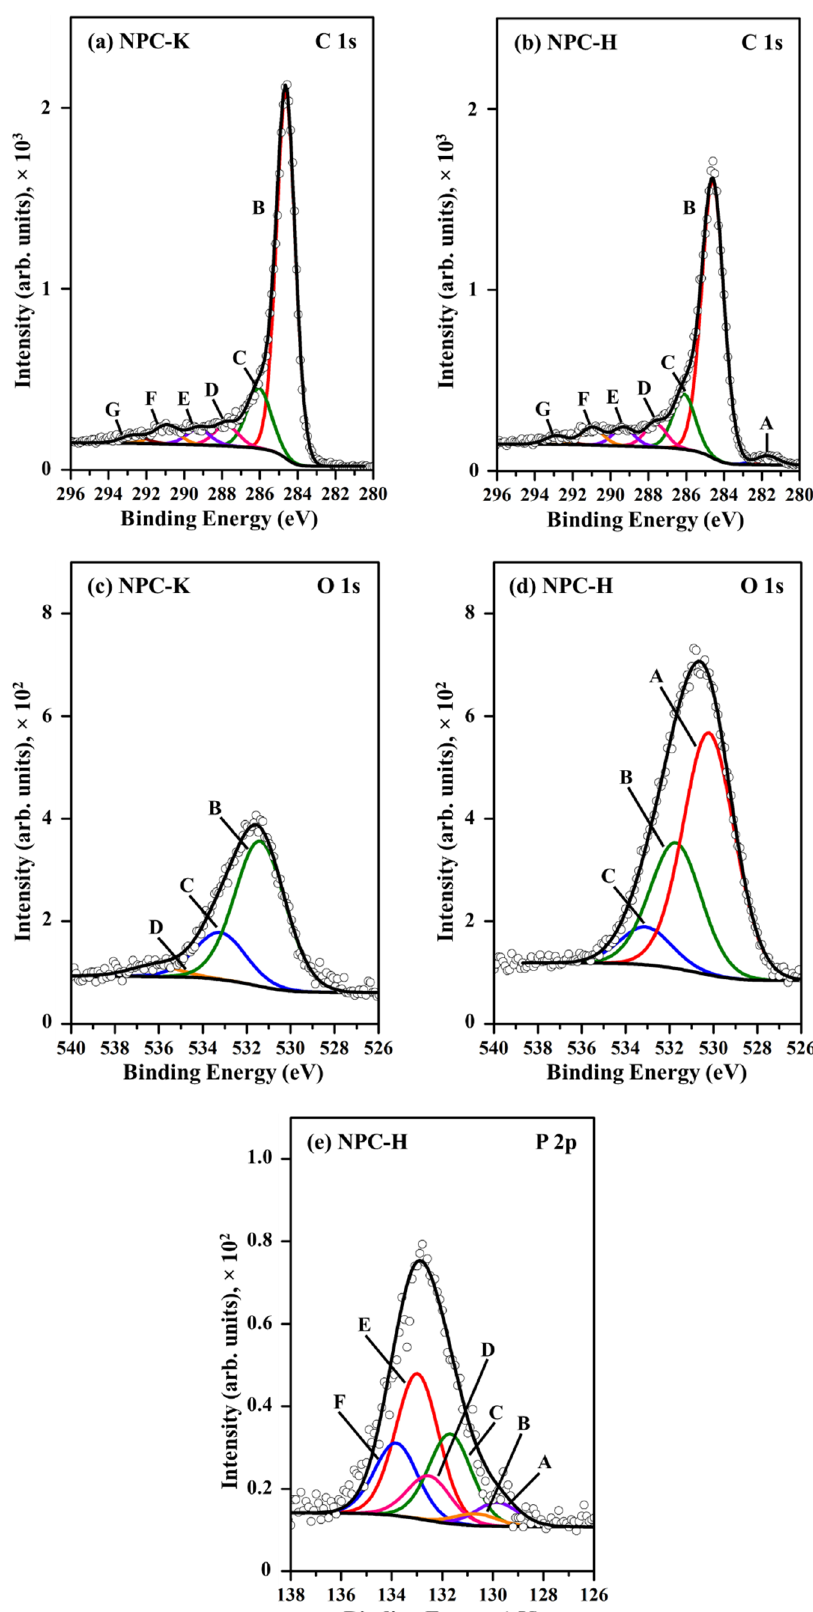
Figure 5. XPS spectrum of C 1s ( a , b ), O 1s ( c , d ), and P 2p ( e ) peak of NPC-K and NPC-H samples, see Table 3.